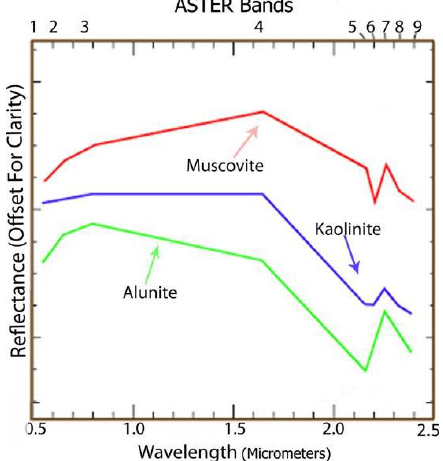
Figure 7. Laboratory spectra of muscovite, kaolinite and alunite resampled to ASTER bandpasses. These minerals, which are common in argillic alteration, have 2.14 and 2.28 μm absorption features (Clark et al., 1993; Mars and Rowan, 2006).